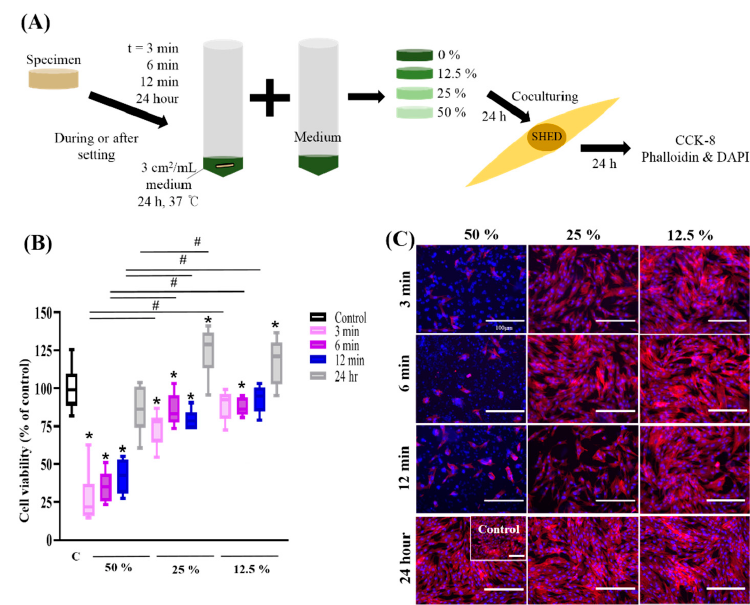
Figure Figure 3. Schematic and results of initial (24 h) cytocompatibility of tricalcium silicate nanoparticle- containing cement (Biodentine™) with human exfoliated deciduous teeth (SHED). ( A ) To evaluate the cell viability of Biodentine™ at different dilution ratios (50%, 25% and 12.5%) and different setting